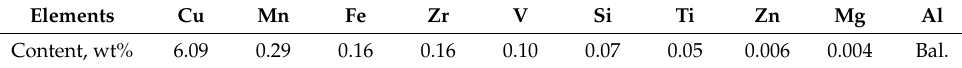
Table 1. Chemical composition of the aluminum alloy 2219 sheets (wt%).